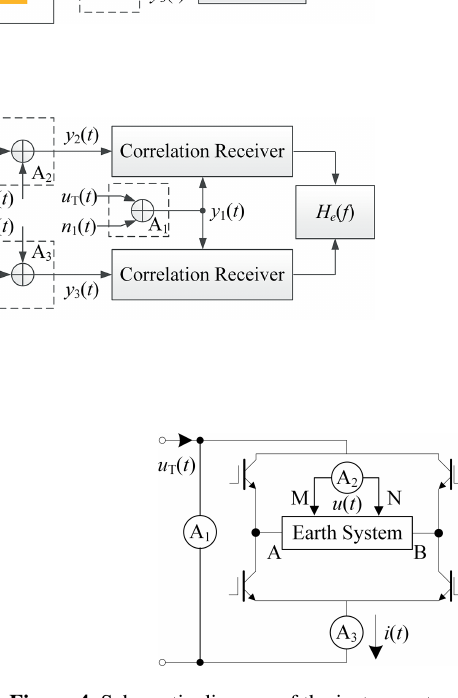
Figure 4. Schematic diagram of the